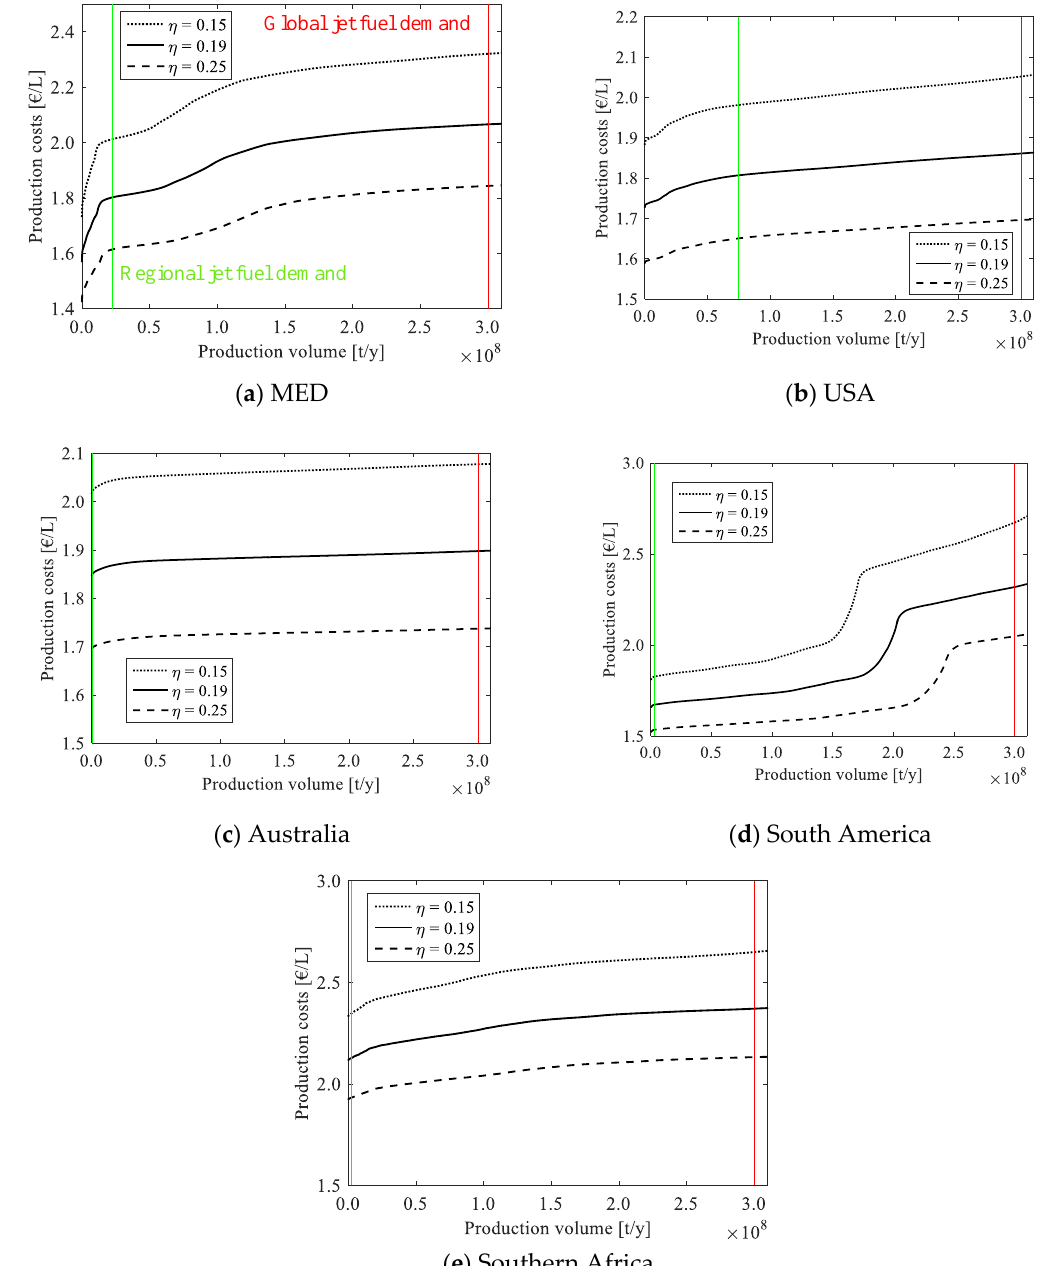
Figure 7. Cost-supply curves of solar thermochemical jet fuel production for ( a ) the MED region, ( b ) the USA, ( c ) Australia, ( d ) South America, and ( e ) Southern Africa. Three values of reactor efficiency are distinguished: 0.15, 0.19, 0.25. The current jet fuel demand is also shown in the selected countries [94] ( green line ) and world jet fuel demand [92] ( red line ). Note that the y-axes represent different intervals.